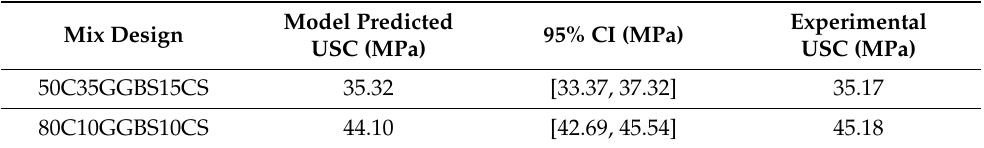
Figure 8. ( a ) 2D and ( b ) 3D response surfaces. Table 7. Predicted and experimental USC after 28 days of